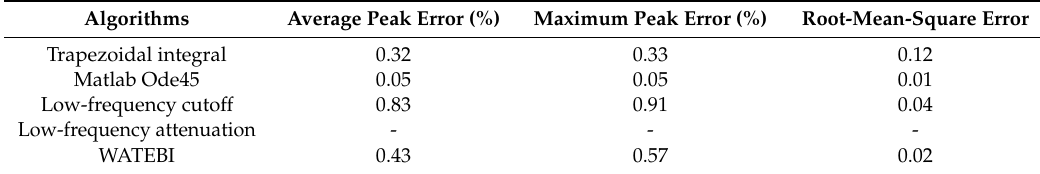
Figure 6. Displacement of the SDOF system: ( a ) Full duration; ( b ) Enlarged detail at the tail end. Table 1. Five methods for the velocity reconstruction of SDOF system.